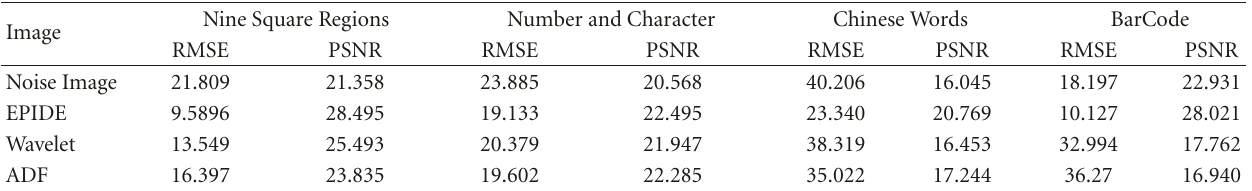
Table 1: RMSE and PSNR (dB) values of the denoised images by EPIDE, Wavelet, and ADF methods. There are four test images “Nine Square Regions”, “Number and Character”, “Chinese Words”, and “BarCode”. Nine Square Regions Number and Character Chinese Words BarCode Image RMSE PSNR